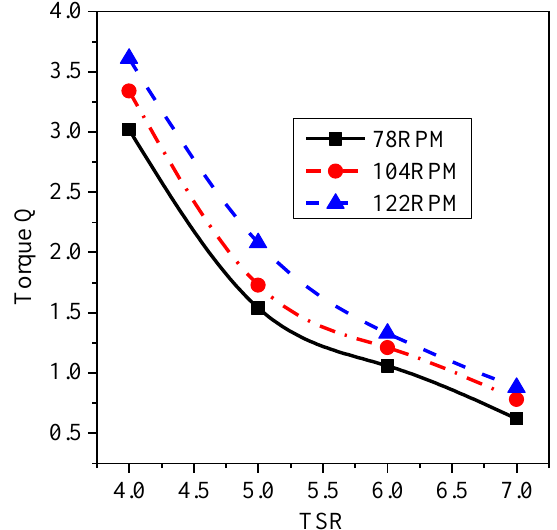
Figure 15. Torque Q changes with TSR.